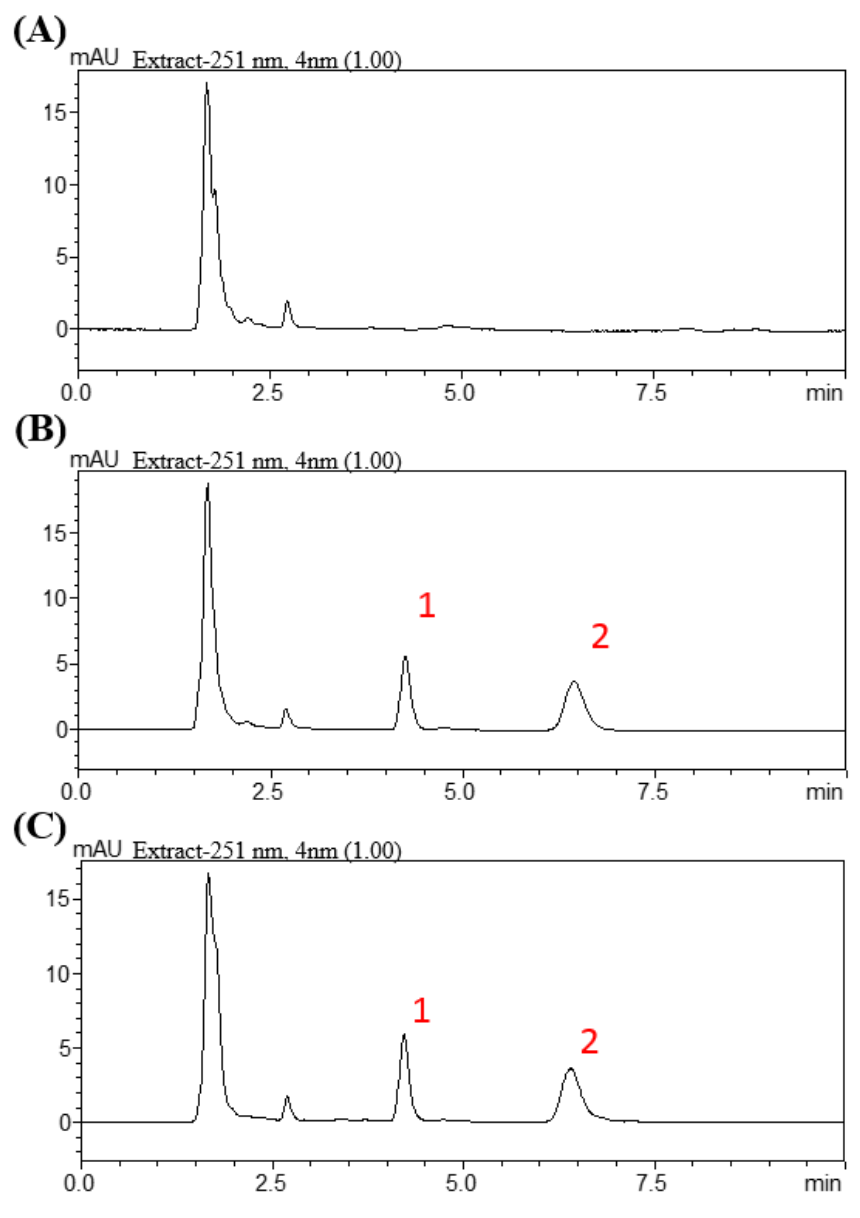
Figure 1. Chromatograms resulting from high-performance liquid chromatography for lenvatinib. ( A ) Blank. ( B ) Blank spiked with lenvatinib (1 μ g/mL) and biochanin A (0.75 μ g/mL). ( C ) Plasma Scheme 60 min after lenvatinib administration (3 mg/kg, p.o.). Peak 1: biochanin A (0.75 μ g/mL). Peak 2: lenvatinib (0.94 μ g/mL).